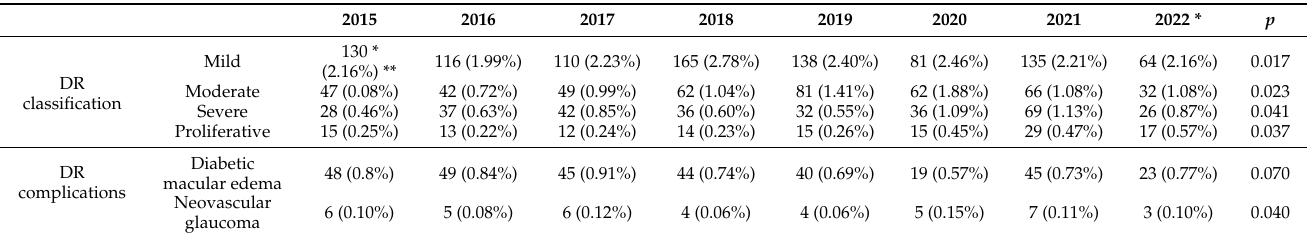
Table 4. Classification of DR and its